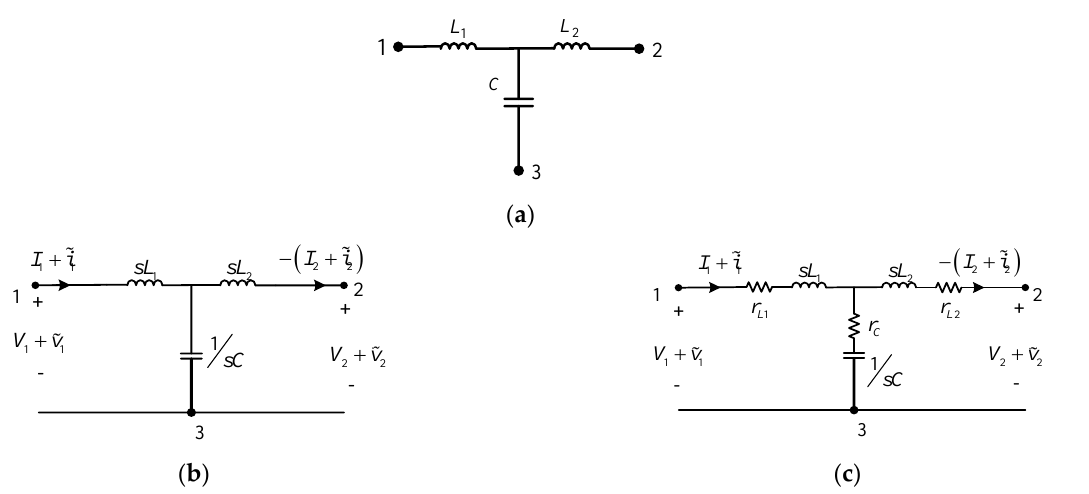
Table 4. Small-signal and steady-state models for the filter block.